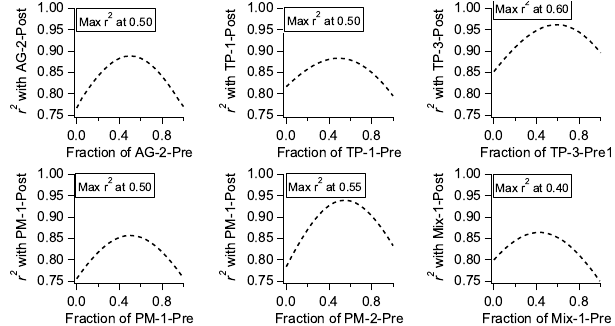
Figure 5. Results from the linear addition optimization for all six experiments where the post-treatment aerosol growth experiment was performed the same day the foliar MeJA treatment was applied. The x axis denotes the fraction of the pre-treatment experiment that was included in the linear addition of the pre-treatment and MeJA standard SOA spectra. The y axis is the correlation of the linear addition spectra with the paired post-treatment SOA spectra. The fraction of pre-treatment SOA included in the linear addition spectra that produced the highest correlation with the paired post-treatment is shown in the box on each graph.